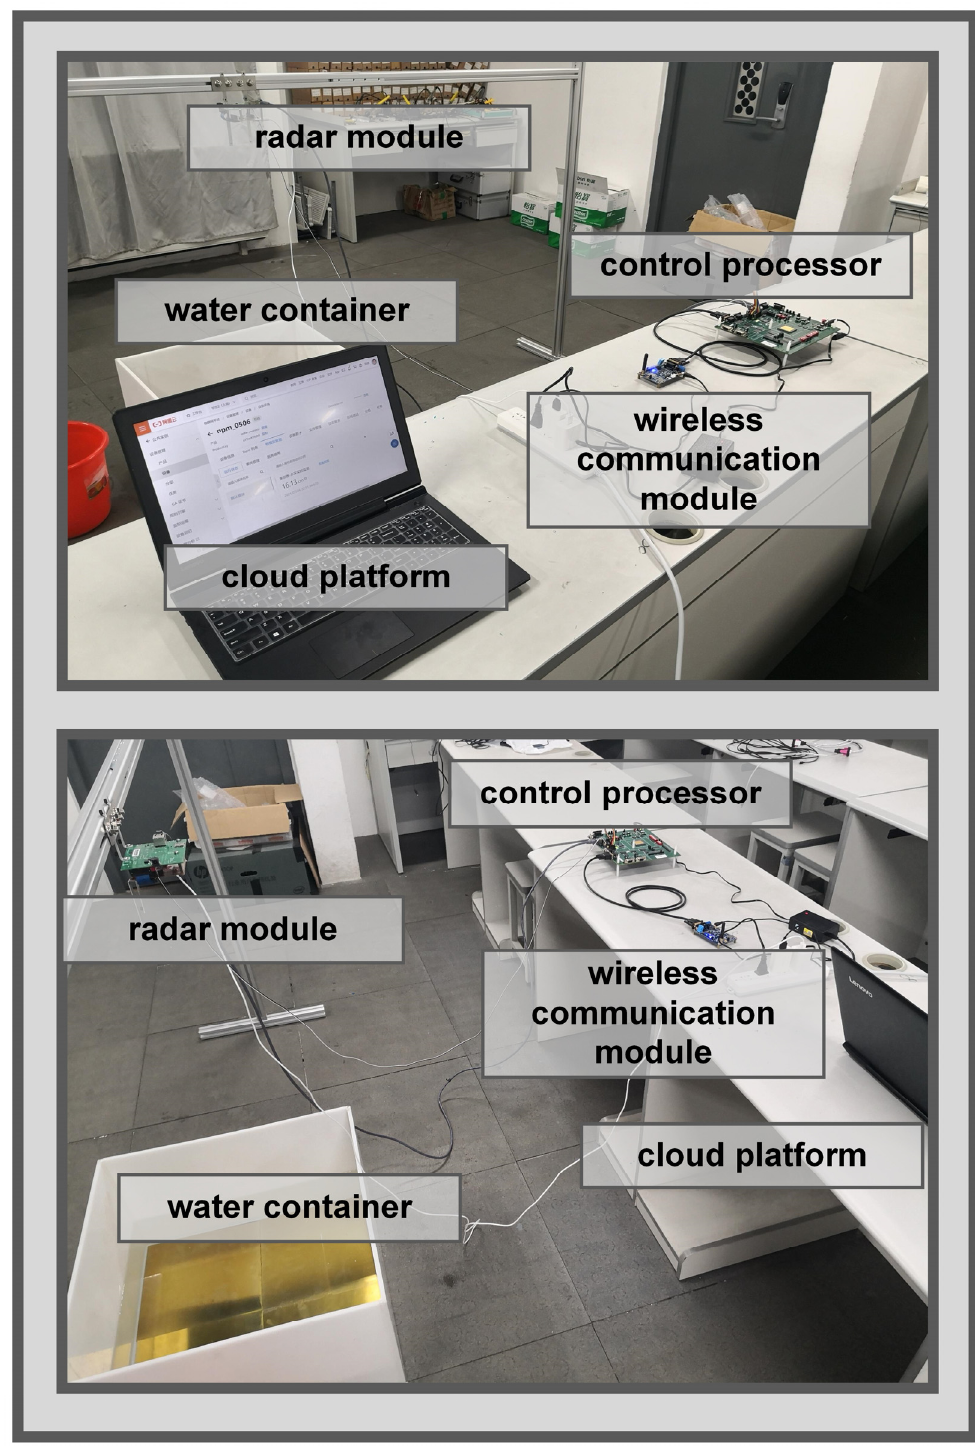
Figure 10. Overall construction of the system photographed from two different